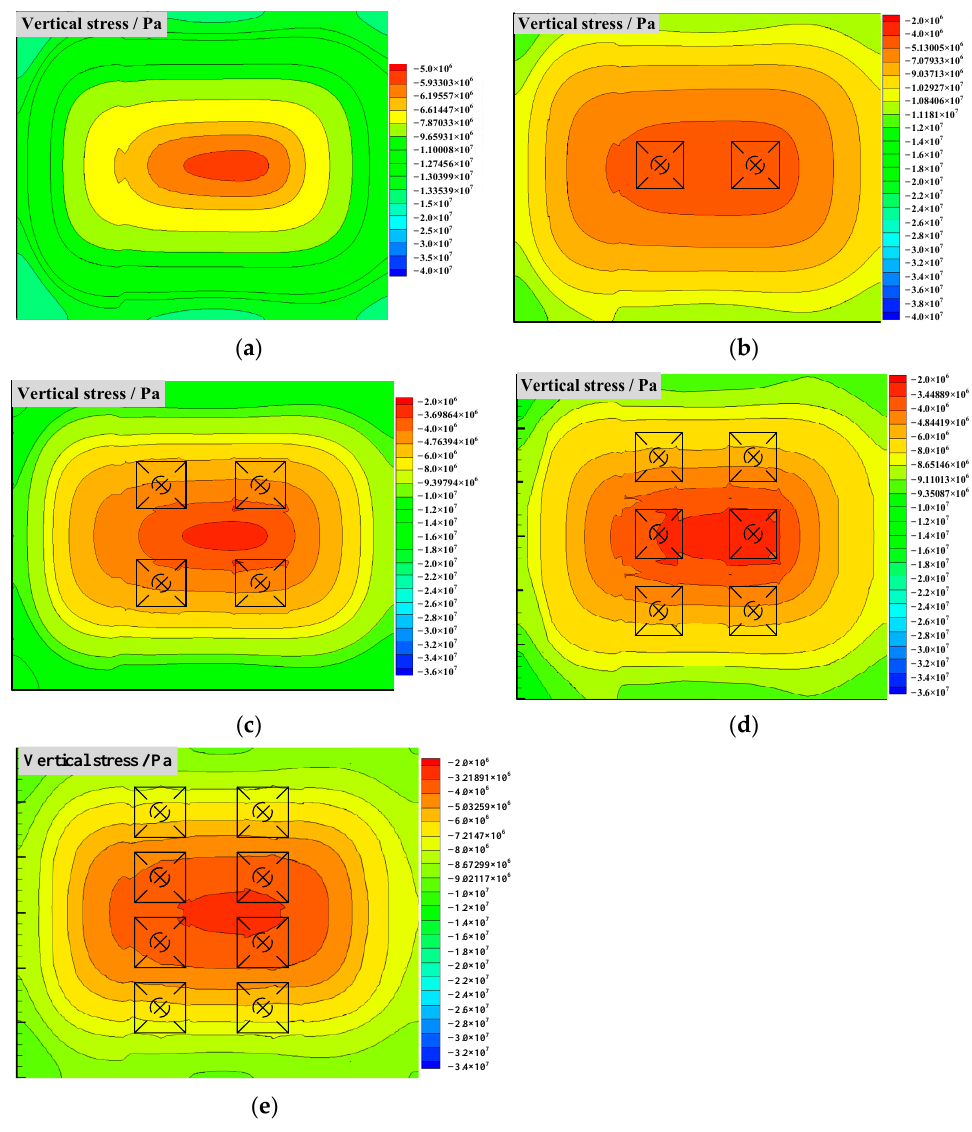
Figure 6. Stress distribution map of backfilling support model for multi-arch pier-column numerical simulation: ( a ) No pier-columns; ( b ) two pier-columns; ( c ) four pier-columns; ( d ) six pier-columns; ( e ) eight pier-columns.